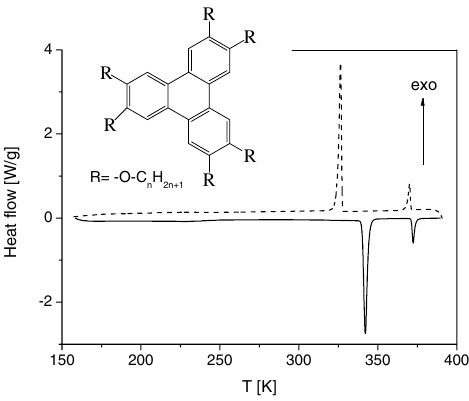
Figure 2. IN6 spectra of HAT6 normalized to the height of the elastic peak: squares – T = 80 K; circles – T = 2K representing the instrumental resolution. The data were averaged over the detector range 54 ... 108 ◦ which is the range from which the VDOS was evaluated. The inset gives g( ω ) /ω 2 of HAT5 (empty circles) and of “amorphous” polyethylene (PE) (filled circles) given by Kanaya et al. [10]. The data for PE are scaled to collapse at the high frequency side with the HAT5